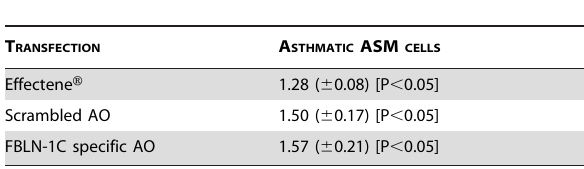
Table 1. mRNA expression of fibronectin in FBLN-1 AO transfected asthmatic ASM cells in the presence of TGF b measured by quantitative real time